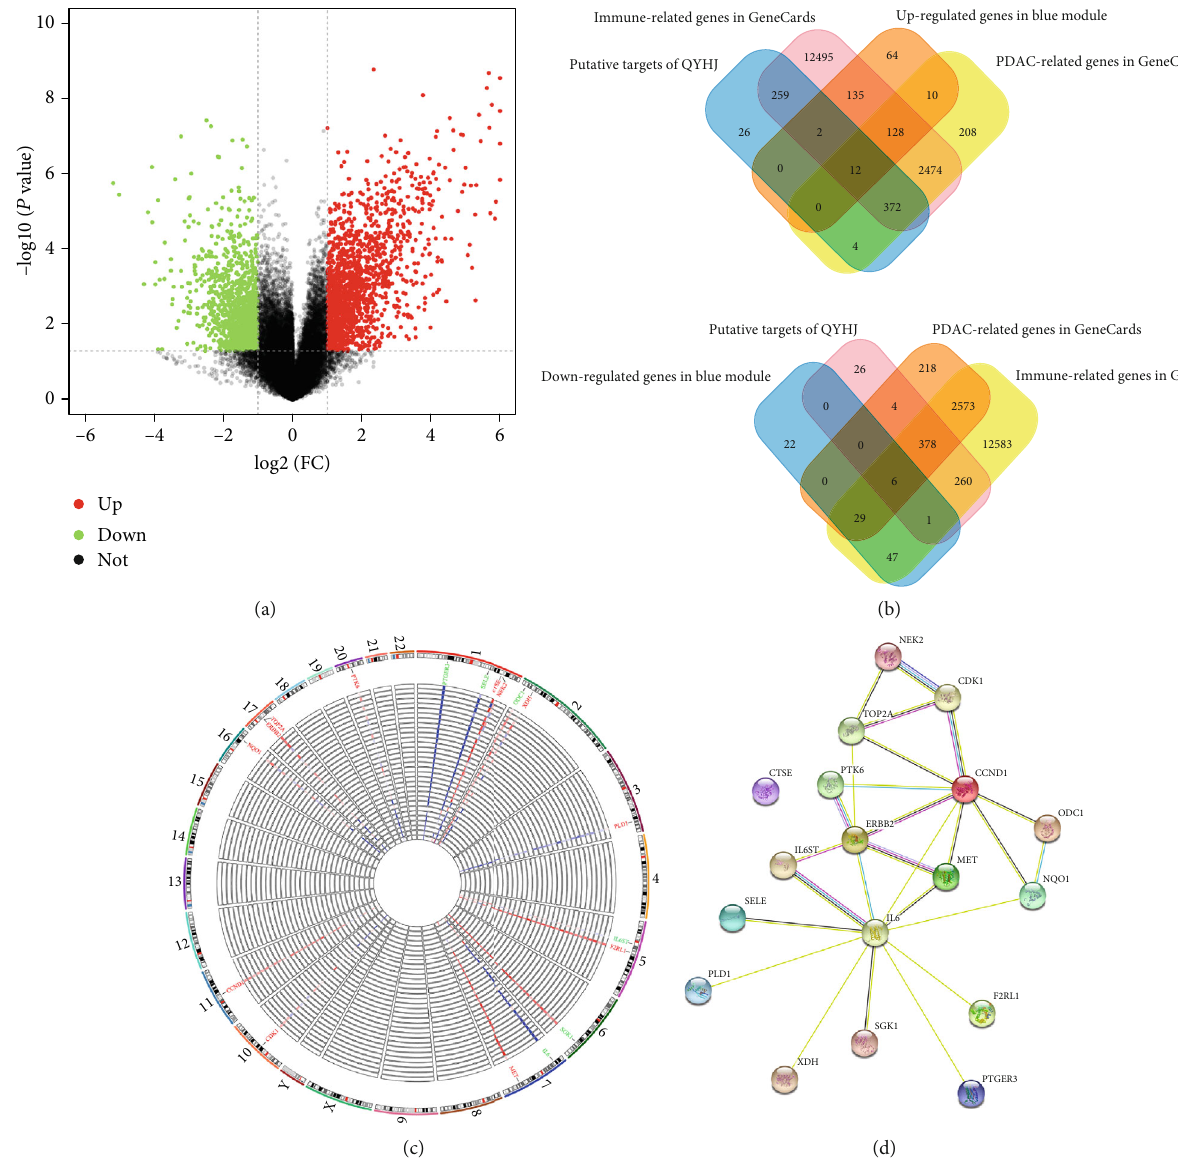
Figure 5: Identi fi cation of OGEs and construction of the PPI network. (a) The volcano plot of di ff erentially expressed genes between cancer and normal samples. The x -axis shows the gene expression di ff erence by a logtransformed fold change while the y -axis shows signi fi cance by – log10 transformed P value value. The red dot represents the up-regulated gene, while the blue dot represents the down-regulated gene. (b) Identi fi cation of immunity-related genes of PDAC with Venn diagram analysis. (c) Circular visualization of expression patterns, and chromosomal positions of OGEs. The 32 samples microarray datasets in GSE32676 are represented in the inner circular heatmaps. Red represents up-regulation, and blue represents down-regulation. Chromosomes were located in the outer circle, lines connected with a speci fi c gene and its corresponding chromosomal locations. The 12 up-regulated and 6 down-regulated genes shown in red and green, respectively. (d) PPI network of